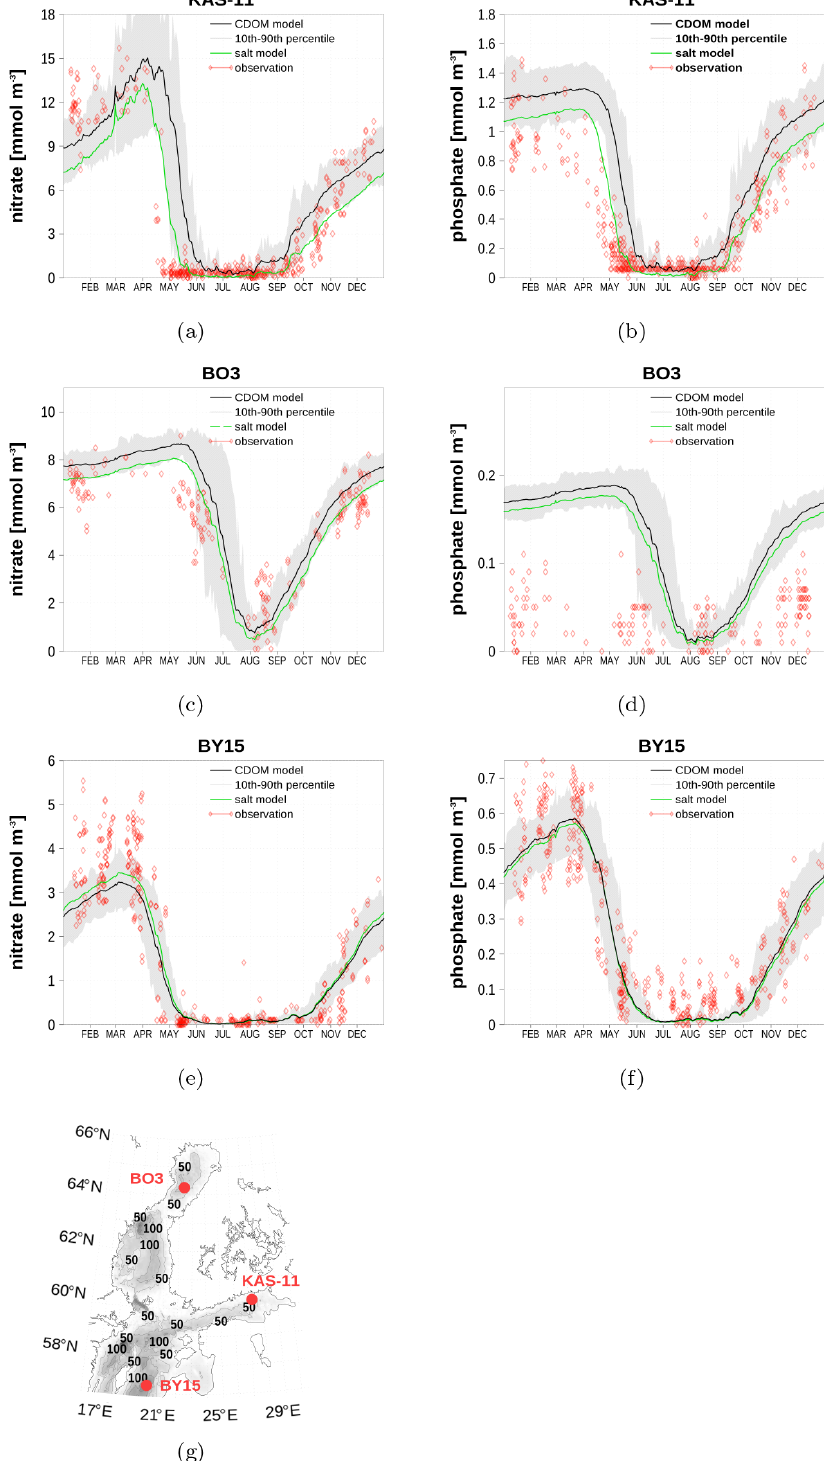
Figure 8. Climatology (1990–2019) of surface nitrate and surface phosphate at three stations. Black lines show the new CDOM-based model, green lines show the salt-based model, and red diamonds are observations (http://www.ices.dk, last access: 19 June 2020). The shaded area is the range between 10th and 90th percentile of the black line. Simulated data are from the 3-nautical-mile model version. The map was created using the software package GrADS 2.1.1.b0 (http://cola.gmu.edu/grads/, last access: 9 August 2021), using published bathymetry data (Seifert et al.,